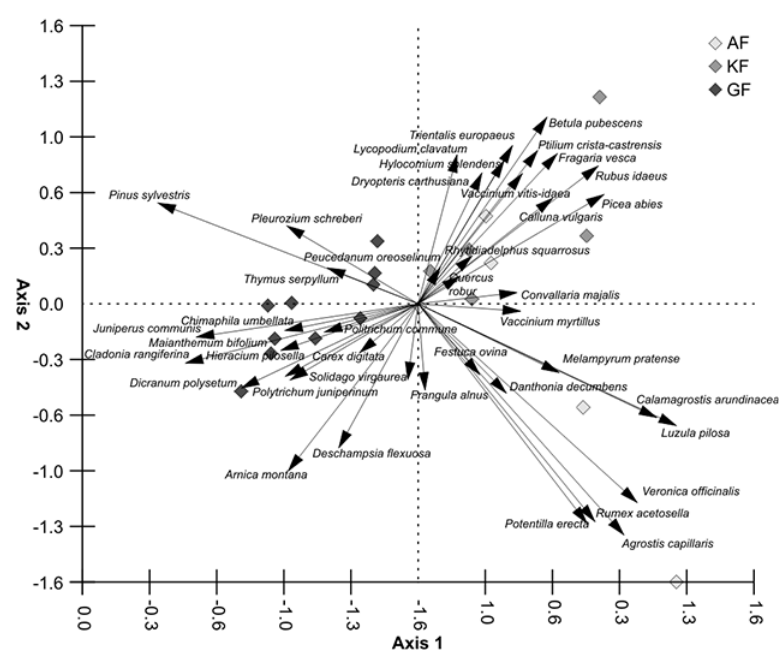
Fig. 2 Results of principal component analysis (PCA) based on the cover of the studied plant species in phytocoenoses with a share of Arnica montana ; AF – Augustów Forest; KF – Knyszyn Forest; GF – Grodno